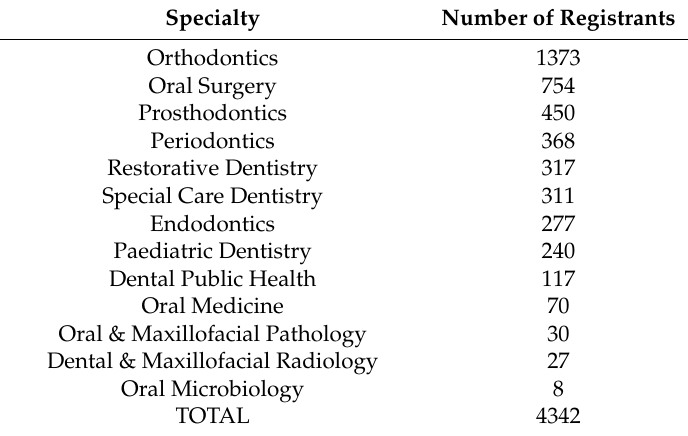
Table 1. Dental specialties recognised by the General Dental Council (GDC) and number of registrants (October